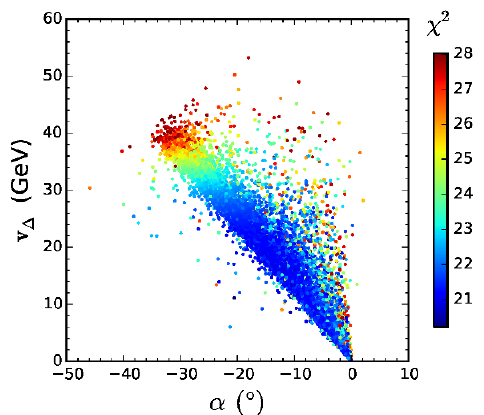
Figure 5 . Scatter plot of the Higgs signal strength (cid:31) 2 (cid:12)t with a 2 (cid:27) range shown in the (cid:11) (cid:0) v the production channels via the gluon fusion ( ggF ), the vector boson fusion (VBF), the associated production with a vector boson ( V h ) and with a pair of top quarks ( tth ), and the decay channels h ! (cid:13)(cid:13); ZZ; W (cid:6) W (cid:7) ; (cid:28) (cid:6) (cid:28) (cid:7) ; b (cid:22) b . With the experimental values of (cid:22) exp